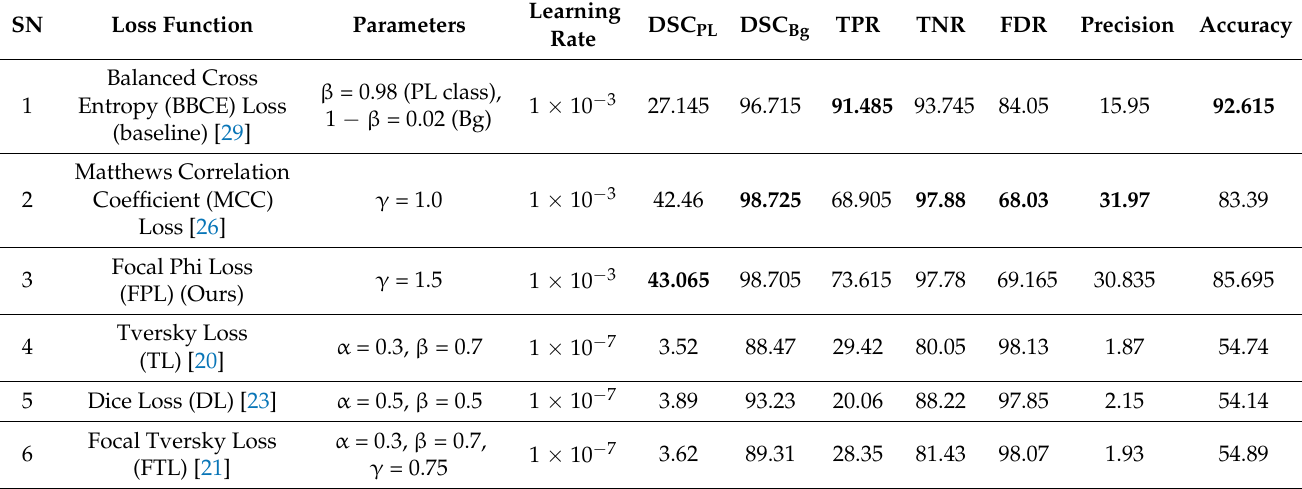
Table 4. Experimental results comparison of various loss functions on PLDU validation dataset with 120